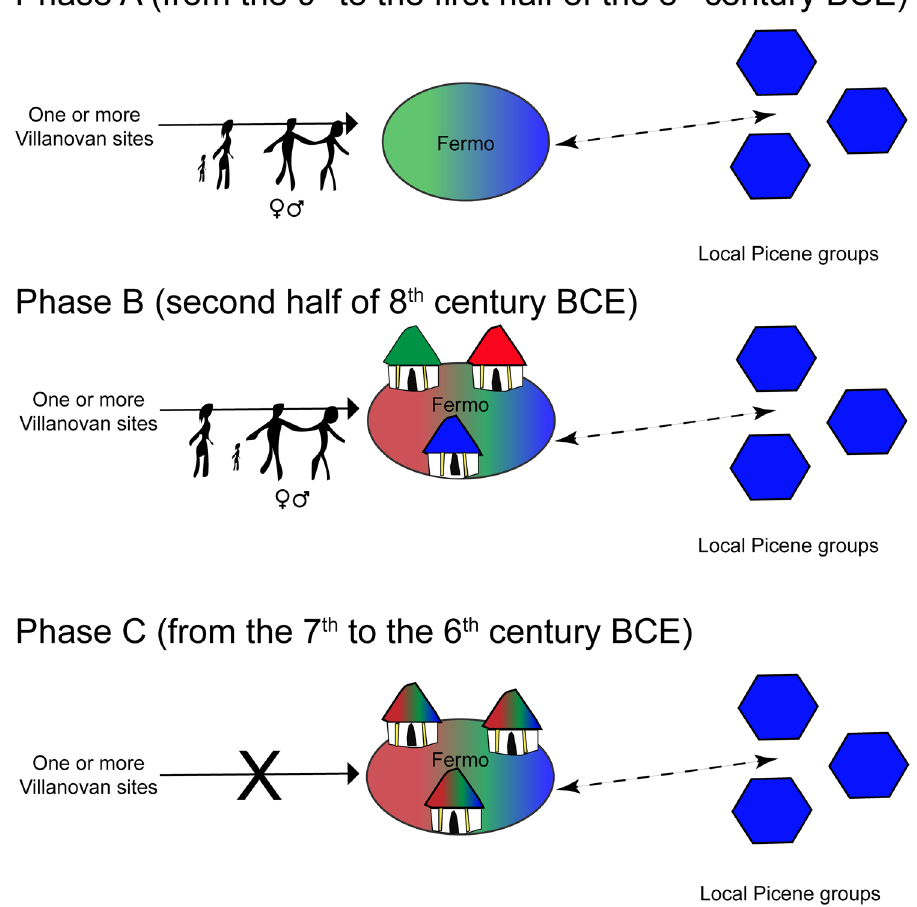
Figure 8. A possible reconstructive model of human mobility at Fermo. Phase A (ninth –first half of the eighth century BCE) male and female individuals arriving at Fermo from one or more Villanovan site(s); Phase B (second half of the eighth century BCE) male and female individuals arriving at Fermo from one or more Villanovan site(s); Phase C (seventh–sixth century BCE) absence of non-local individuals according to 87 Sr/ 86 Sr analysis. Black arrow: human mobility; dashed arrow: unknown relationship (based on archaeological record